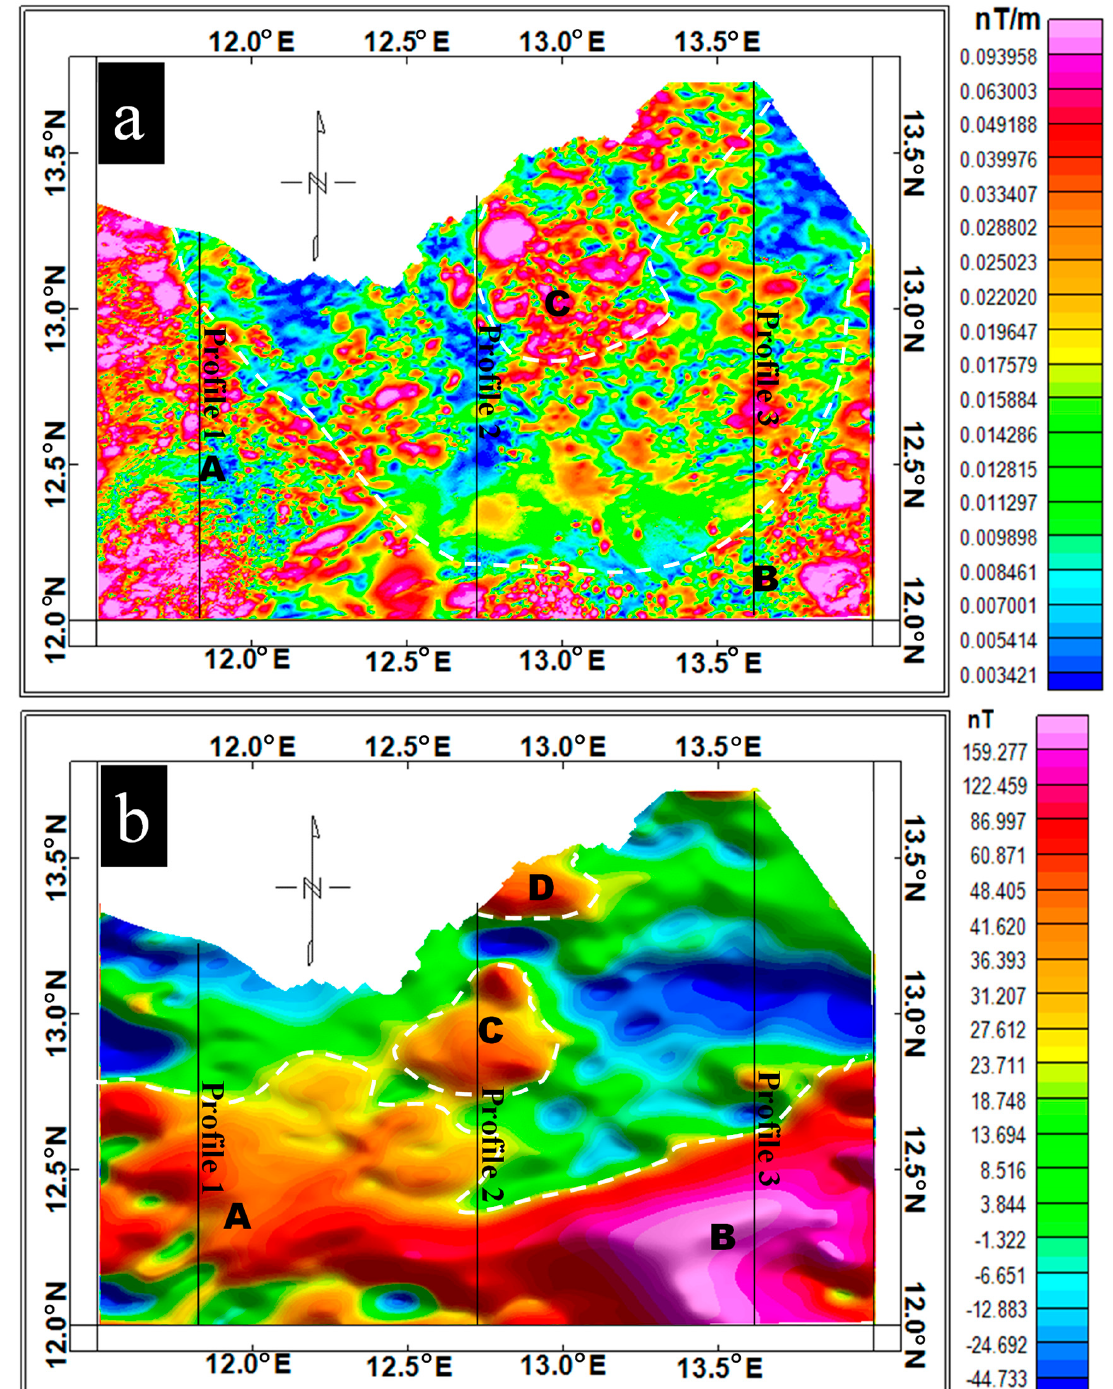
Figure 8. ( a ) Analytic signal and ( b ) total magnetic intensity data upward continued 5000 m